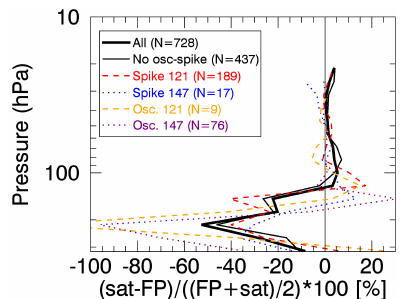
Figure A3. Comparison between Aura MLS WV and frost point (FP) hygrometer sounding data (similar to Fig. 3), separated by category of UTLS oscillation in the MLS